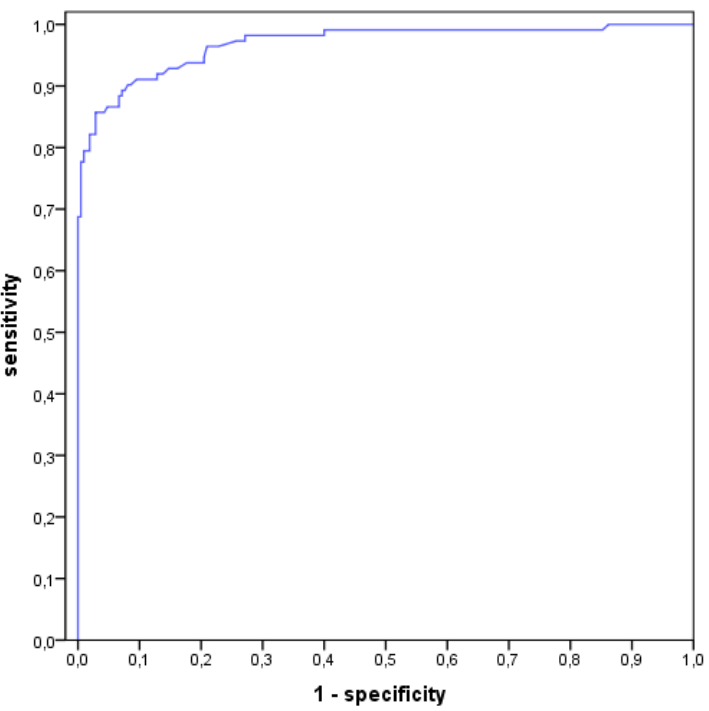
Figure 7. Receiver operating characteristics curve (ROC-curve) with the calculation of the threshold of cell count at a value of 1400 cells/ μ L with a sensitivity of 90.2% and specificity of 91.9%.